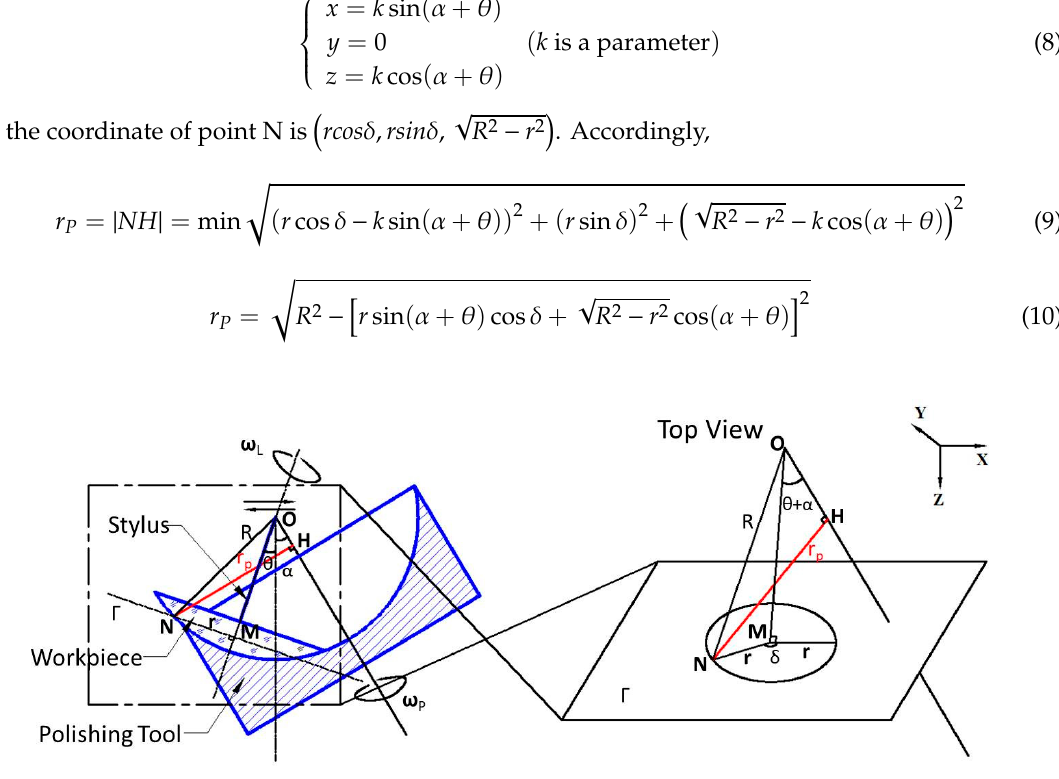
Figure 5. Geometric of the process.